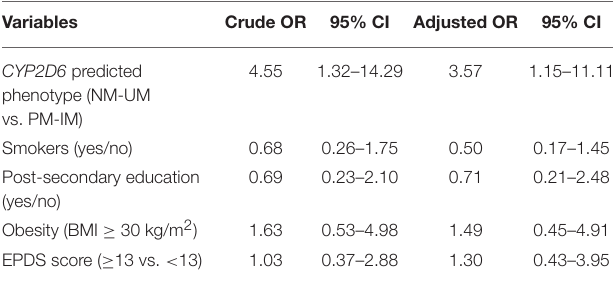
TABLE 3 | Genotype-predicted CYP2D6 phenotype and the risk of antidepressant discontinuation during pregnancy. Variables